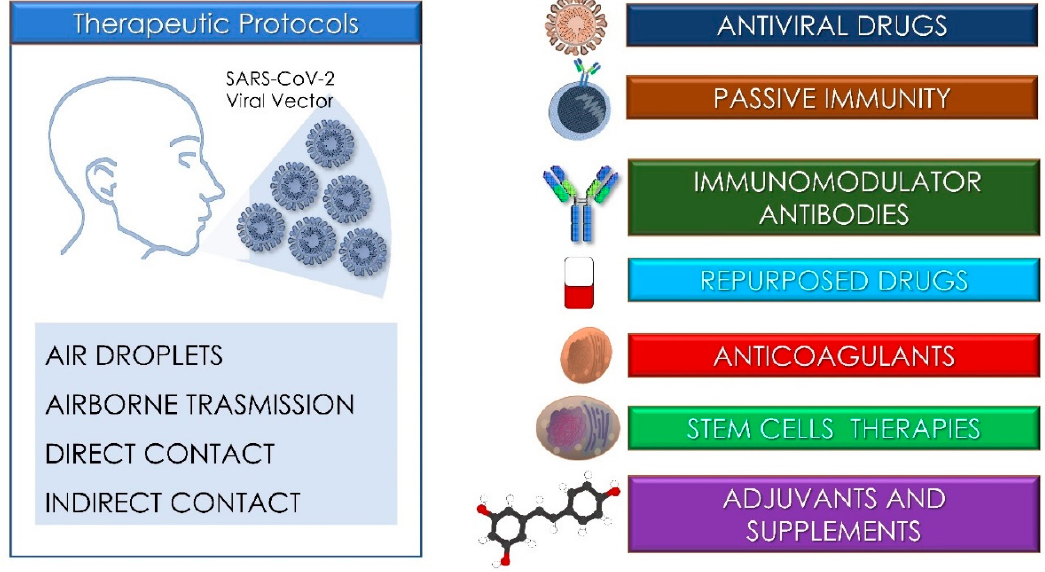
Figure 2. Summary of the therapeutic drug categories proposed against COVID-19.